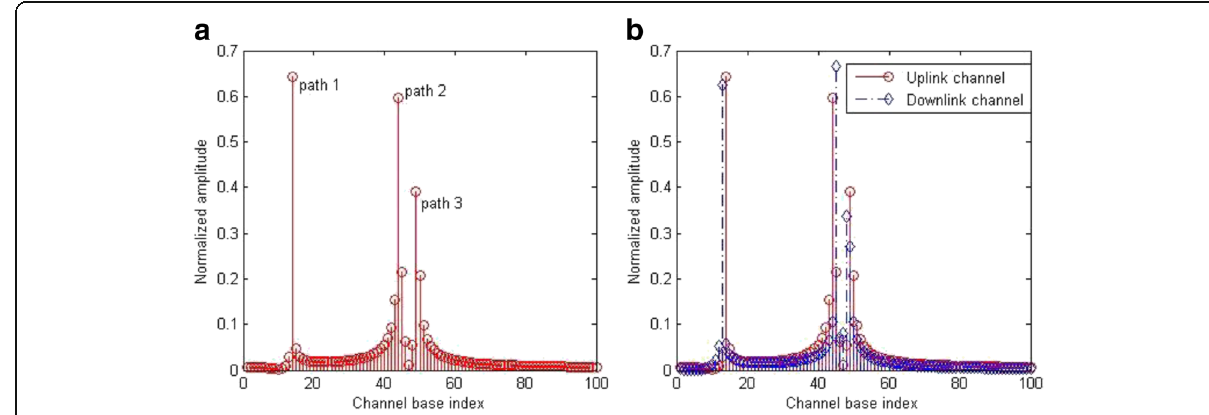
Fig. 2 a Sparsity in spatial channel and b uplink and downlink supports with angle